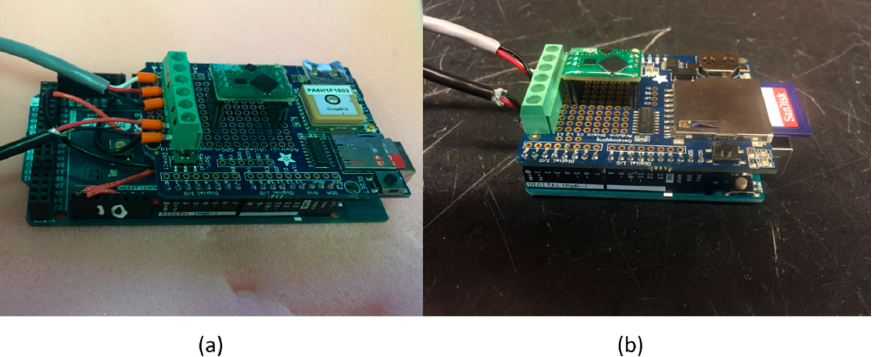
Figure 1. Assembled Arduino based sonde for ( a ) the drifter application and ( b ) the moored application.